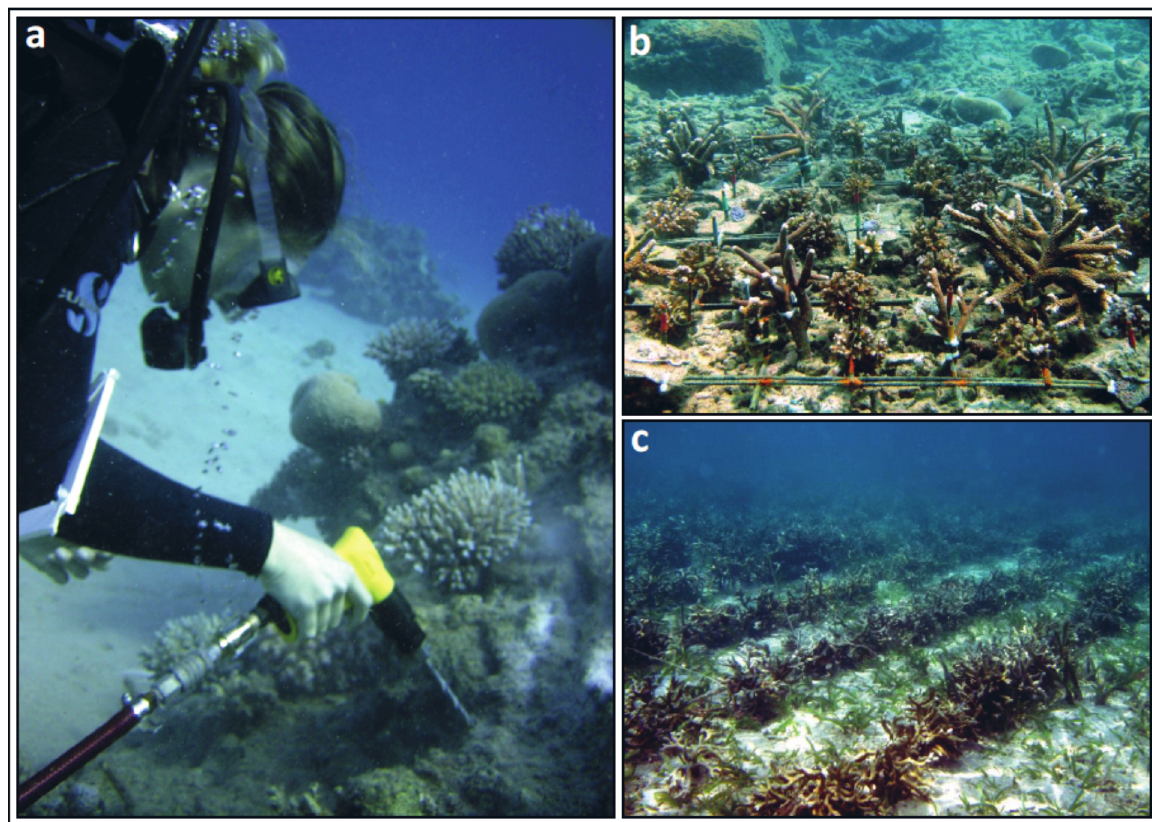
Figure 1. Part of the transplantation protocols associated with the “gardening” tenet of reef restoration. ( a ) Transplanting coral colonies from Eilat’s nursery (the Red Sea, Israel) onto hard substrate. The plastic pegs covered with the farmed coral colonies (6–9 cm diameter each, initiated from 1 to 2 cm fragments that were nursed for 8–14 months) were manually cleaned of fouling organisms using scrub sponges and scratching tools and cemented into pre-drilled holes (made by pneumatic drills powered by pressured air from SCUBA cylinders) at fixed distances of 20 cm. This new transplantation practice enabled coral attachment on horizontal as well as vertical substrates, allowing maximum transplantation coverage of the target area without any required prior preparation of the substrate, while inflicting a negligible impact on substrates adjacent to the transplants (photograph by Y. Horoszowski-Fridman). ( b ) Transplantation of nursery farmed corals on rubble: Iron meshes (20 × 20 cm holes), usually used for cement floors, were each cut into 1 × 1 m square units and immobilized by iron bars inserted at each of the four corners and a single centered bar. Several units were put next to each other on the sea floor to create larger transplantation areas. Metal segments measuring 4 cm were cut out of the mesh bars, leaving 8 cm on each side, and then the last 3 cm of the left bars were bent upwards vertically to create a “peg”, leaving 10 cm distances between the “pegs”. Corals were tied to the pegs using cable ties (photograph by G. Levi). ( c ) Transplantation of “rope nursery” [30] corals onto soft bottoms in Thailand: The ropes carrying the farmed coral colonies were cut into 2 m long segments, laid on the soft substrate and connected to pre-inserted iron bars by cable ties, preventing excessive movement. The figure presents sparse transplantation where the ropes were put in parallel to each other, at 50 cm distances (photograph by G.